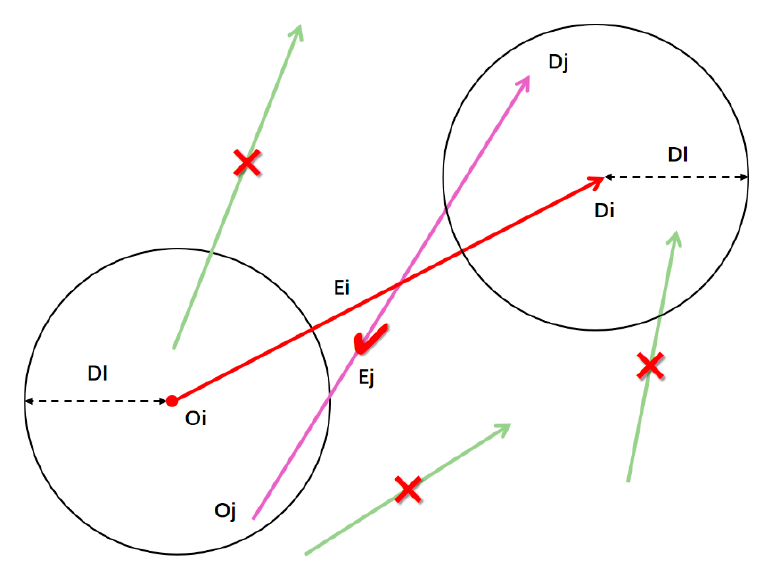
Figure 4. Spatial constraints for edge similarity determination.